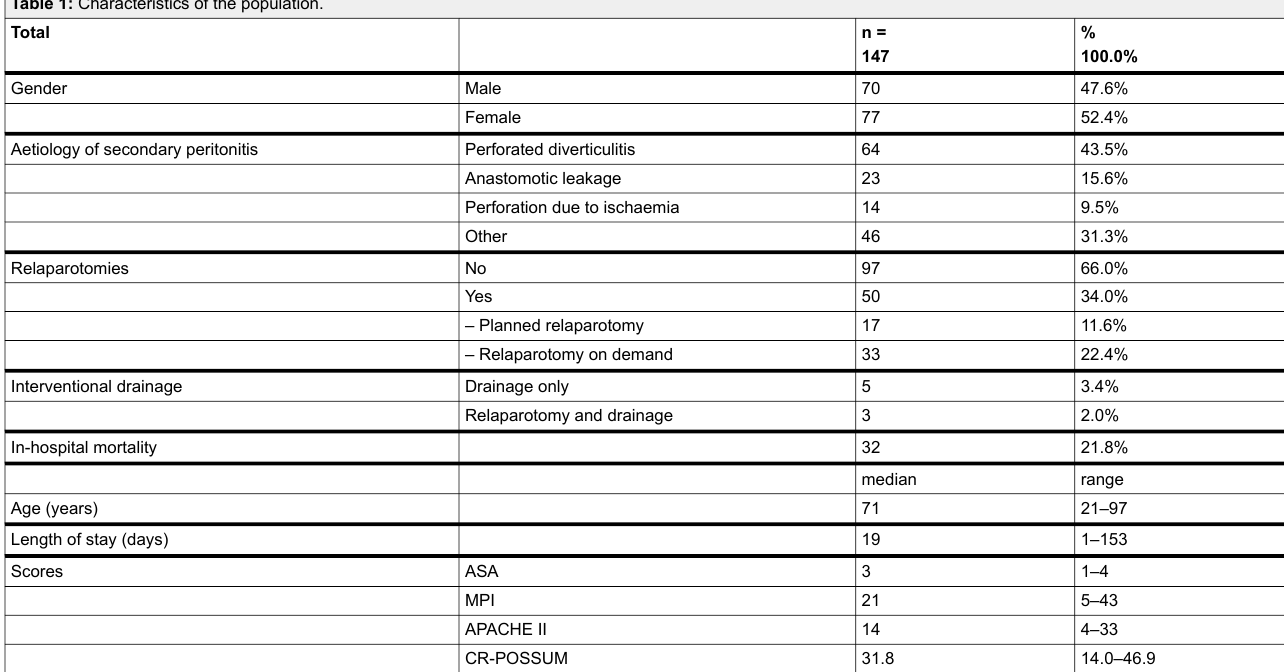
Table 1: Characteristics of the population.